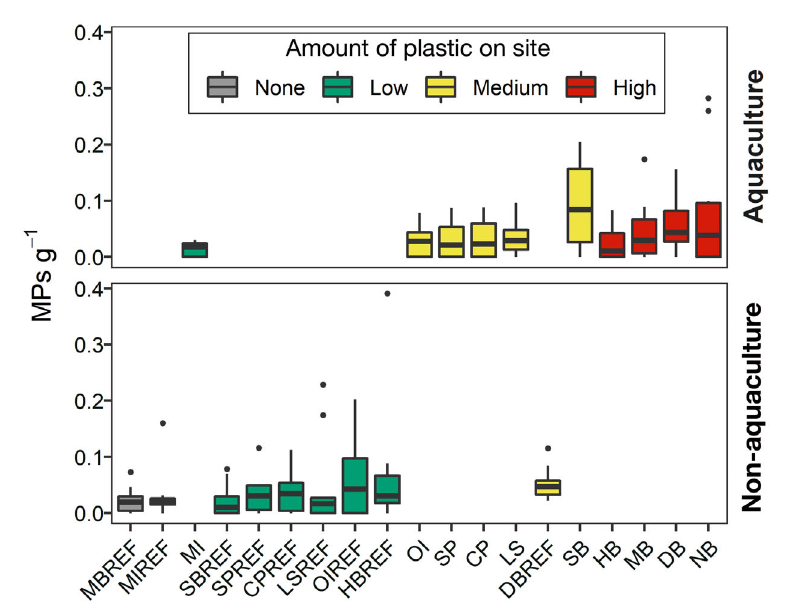
Fig. 7. Boxplots (as defined in Fig. 5) of microplastic particle (MP) concentra- tions in Pacific oysters Crassostrea gigas at 19 study sites (aquaculture and